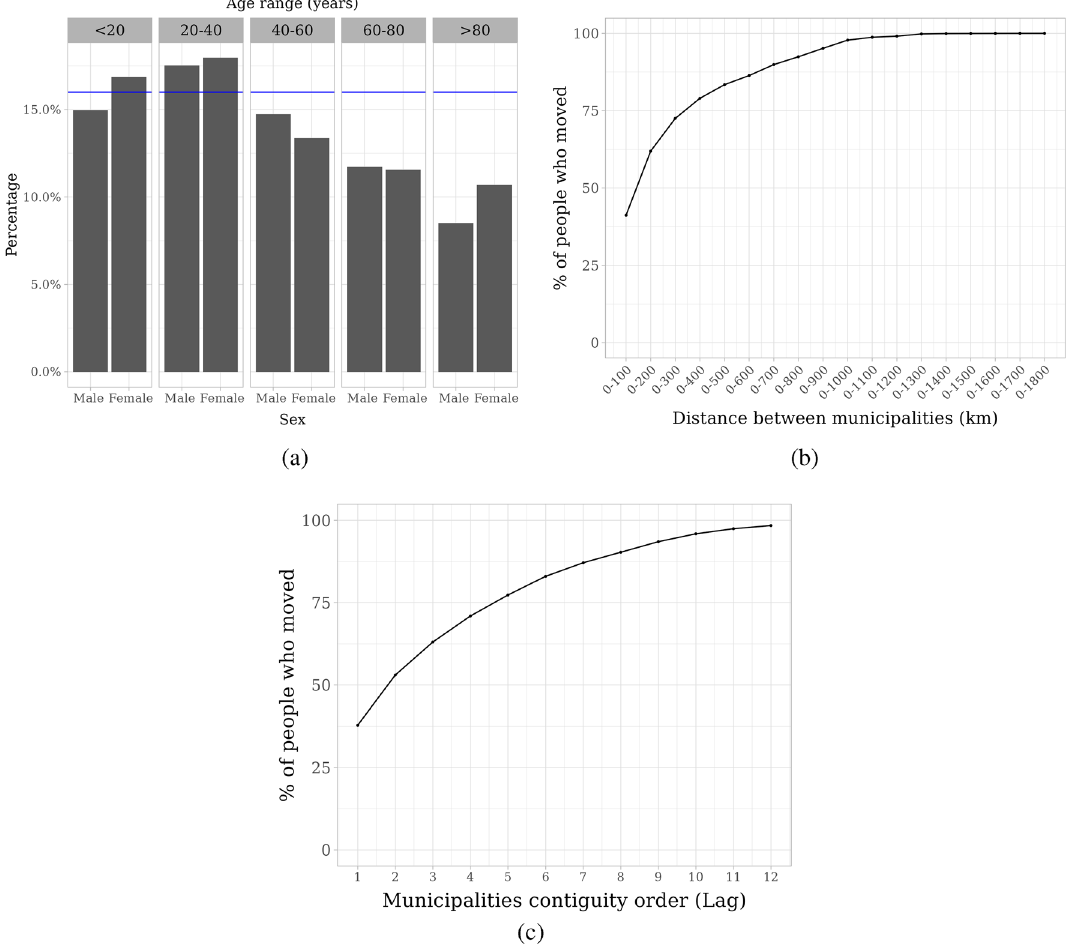
Figure 1. Cross-municipality migration rate stratified by demographics among people with laboratory- diagnosed tuberculosis ( a ) and stratified by distance ( b ) and contiguity between origin and destination municipalities ( c ) among people who moved. We calculated migration rate as the percentage of migrants among people with at least two clinic visits in each group. We defined migrants as people with